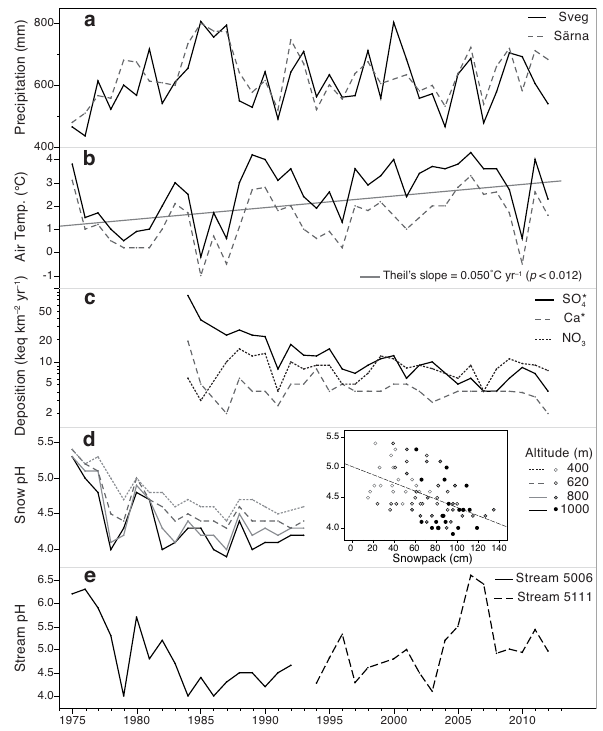
Fig. 2. Overview of time series: (a) and (b) annual precipitation and annual mean temperature at two weather monitoring stations 40kmE (Sveg) and SW of the Study area. The straight line repre- sents Theil’s slope fitted to the mean of data from both temperature curves. (c) Annual deposition of SO ∗ , NO 3 , and Ca ∗ at the pre- 4 cipitation monitoring site Djursvallen, close to stream Djursvasslan (5004) in Lofsdalen, 1984 to 2009 (“*” indicates the non-marine fractions). Note that the y axis is log-transformed to facilitate com- parison. (d) Snow pH at different altitudes above seal level. Snow cores were collected in April 1975–1993 (data from Erik Olofs- son, Sveg, municipality of Härjedalen). The embedded graph il- lustrates the relationship between pH and snow depth. (e) Annual min pH of stream water from two nearby stream-sampling stations; Djursvålsbäcken (5006) before liming and never limed Övre Häg- gingån